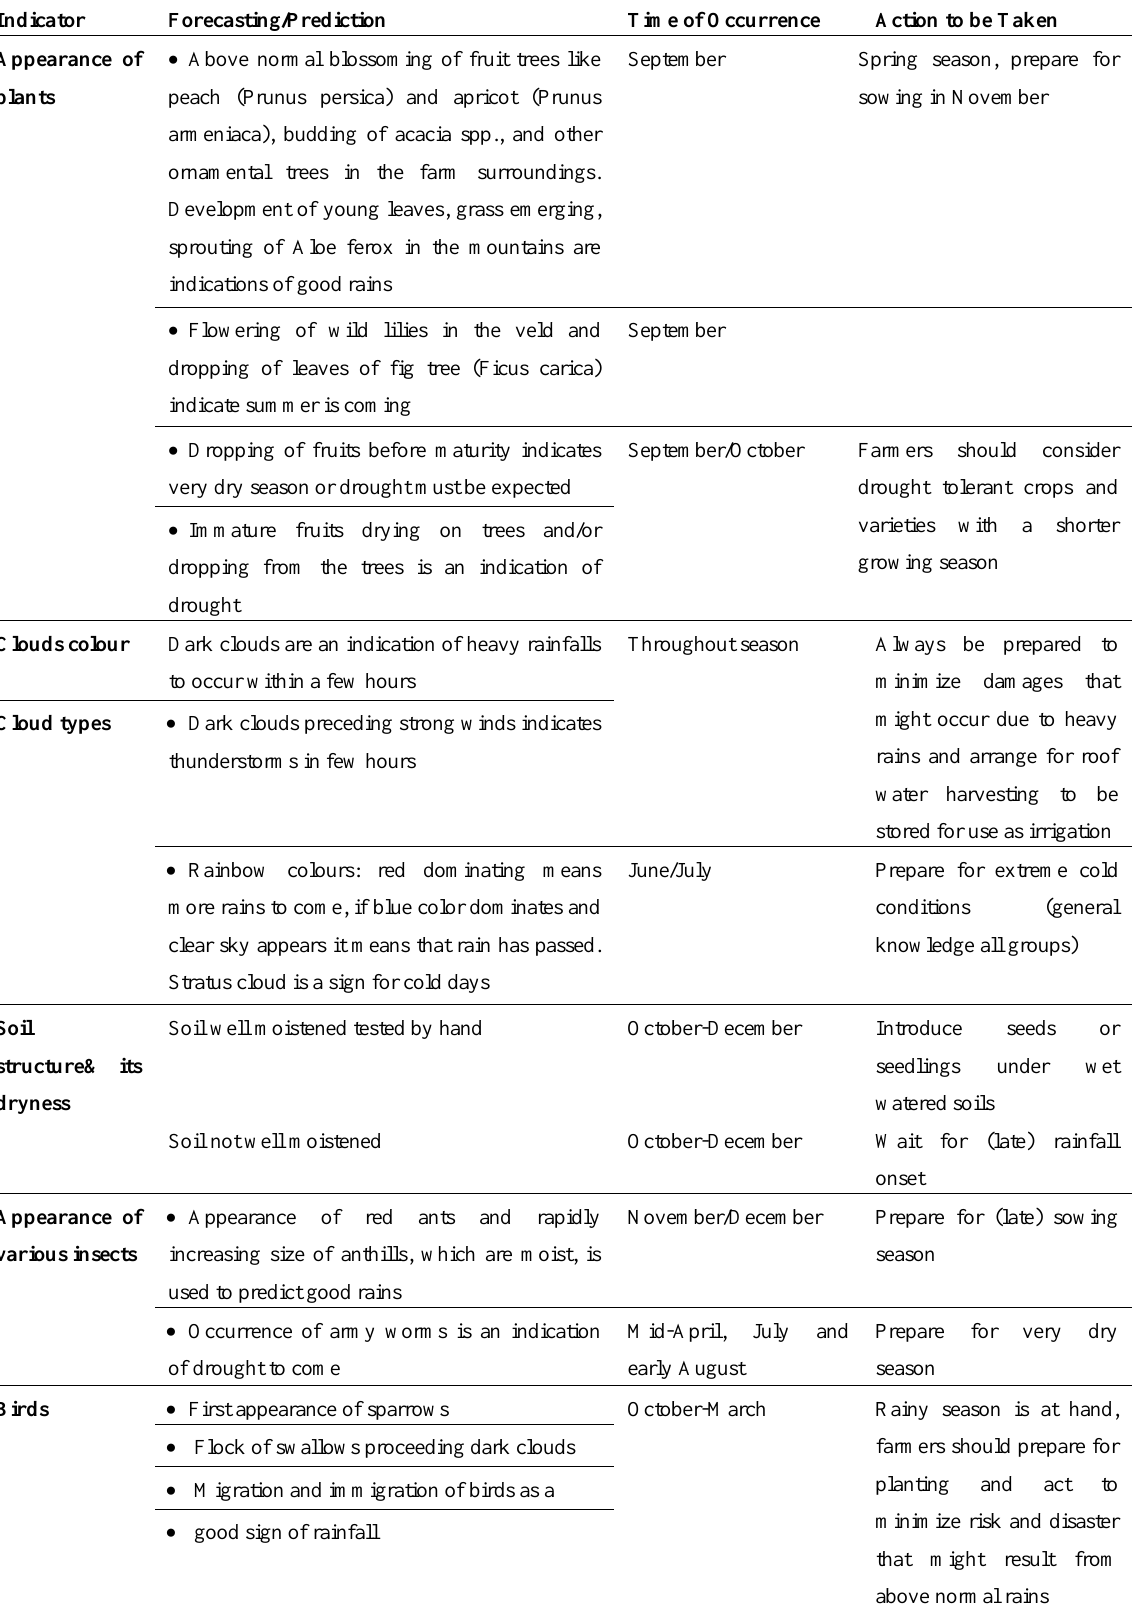
Table 2. Traditional weather forecasting and climate prediction indicators related to rainfall conditions as derived from interviews with farmers in 2008 and 2012